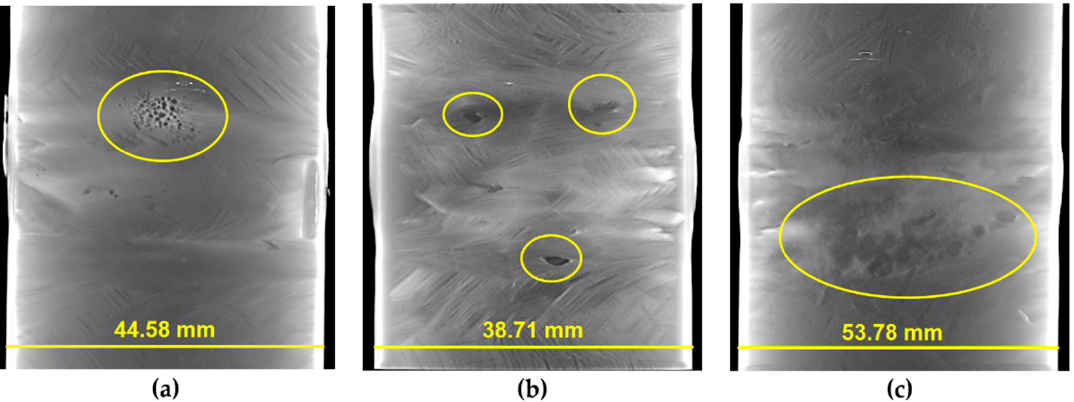
Figure 2. Defects evaluation for specimens of type-NC-2 joints: ( a ) specimen 766-FM-2; ( b ) speci- men 766-FM-3 and ( c ) specimen 766-FM-4.